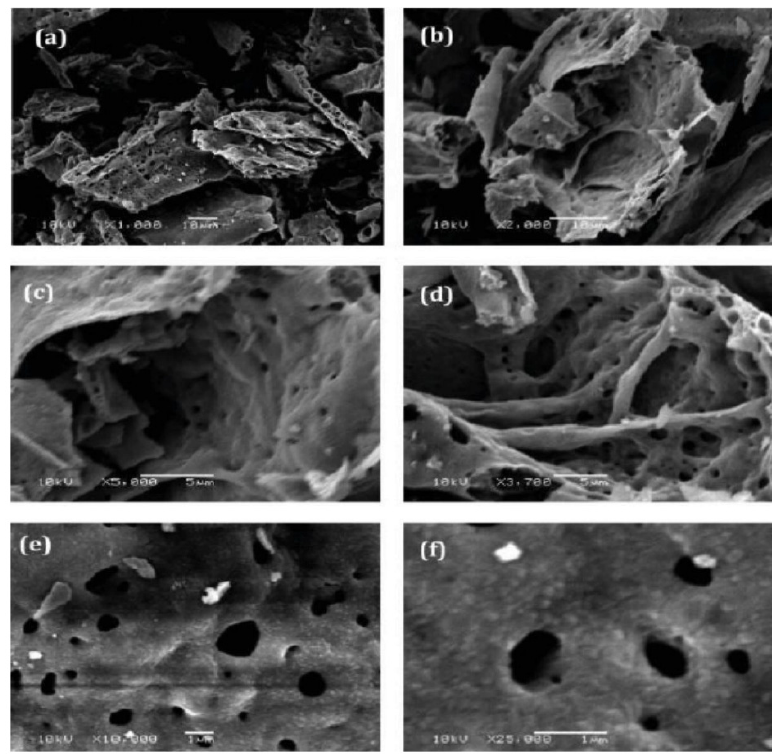
Figure 7. SEM images for nanocrystalline Li 4 Ti 5 O 12 at different magnifications synthesized by combustion method. Reproduced with permission from [110]. Copyright American Chemical Society, 2013.